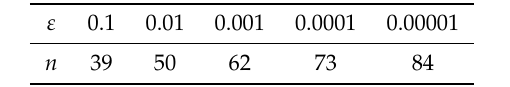
Table 9. Number n of iterations needed by the a priori estimate if started with ( 10,50 ) .